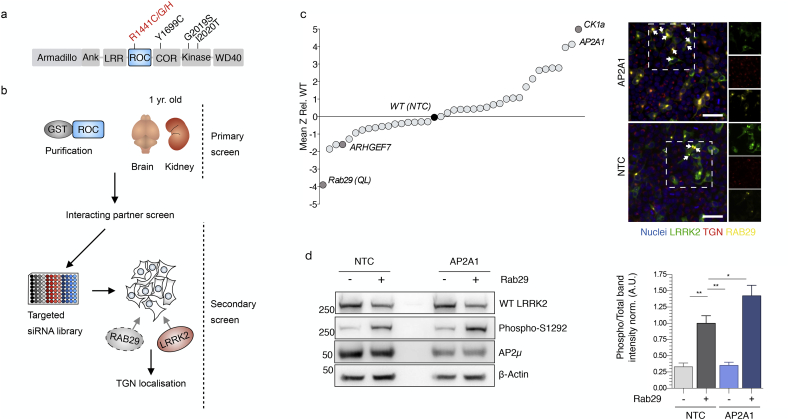
siRNA screen for modifiers LRRK2-TGN localization (a) Diagrammatic representation of full length LRRK2 with PD associated mutations annotated. ROC domain is highlighted. (b) Outline of sequential screening strategy. Primary screen involved a protein-protein interaction screen using the purified ROC domain, a secondary screen assayed endogenous knockdown of selected candidates to assess modification of RAB29-dependent LRRK2 relocalisation. (c) Effects of knockdown of candidates on LRRK2 TGN localization. Mean Z scores from two independent screens were calculated relative to cells transfected with wild type RAB29 and treated with a non-targeting control siRNA (WT (NTC), black) and ranked according to effect size. Dark grey shaded points indicate positive controls. AP2A1 emerged as a strong positive regulator of LRRK2 TGN relocalisation compare to non-tageting control siRNA (NTC) (MeanZ, 4.1338, AdjP, 0.0002. Scale bar indicates 50 μm and applies to all images). (d) AP2A and RAB29 both regulate LRRK2 S1292 autophosphorylation. Cells transfected with plasmid (−) or RAB29 (+) were also treated with siRNA against AP2A1 or a non-targeting control (NTC) were immunblotted for the indicated proteins. Markers on the left of all blots are in kilodaltons. AP2A1 knock down following single transfection of LRRK2 did not significantly affect kinase activity. However, depletion of endogenous AP2A in the presence of RAB29 promotes kinase activity of LRRK2 (n = 6; AdjP, 0.0486, P < .05*; One-way ANOVA with Dunnett's multiple comparisons test).